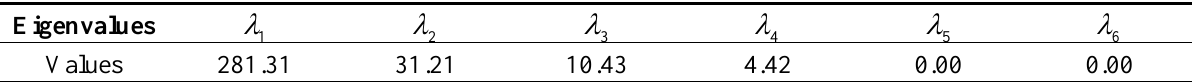
Table 1. The eigenvalues of the covariance matrix for the mixed signals.